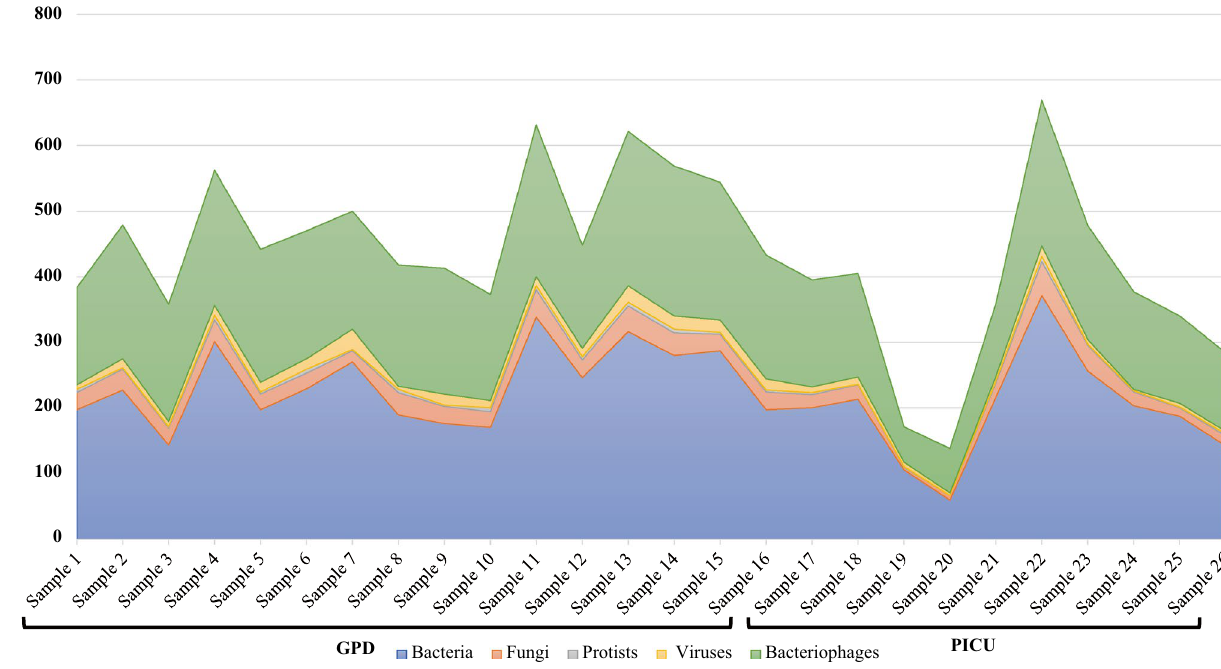
Figure 1. Distribution of different types of microorganisms across the 26 mobile phone